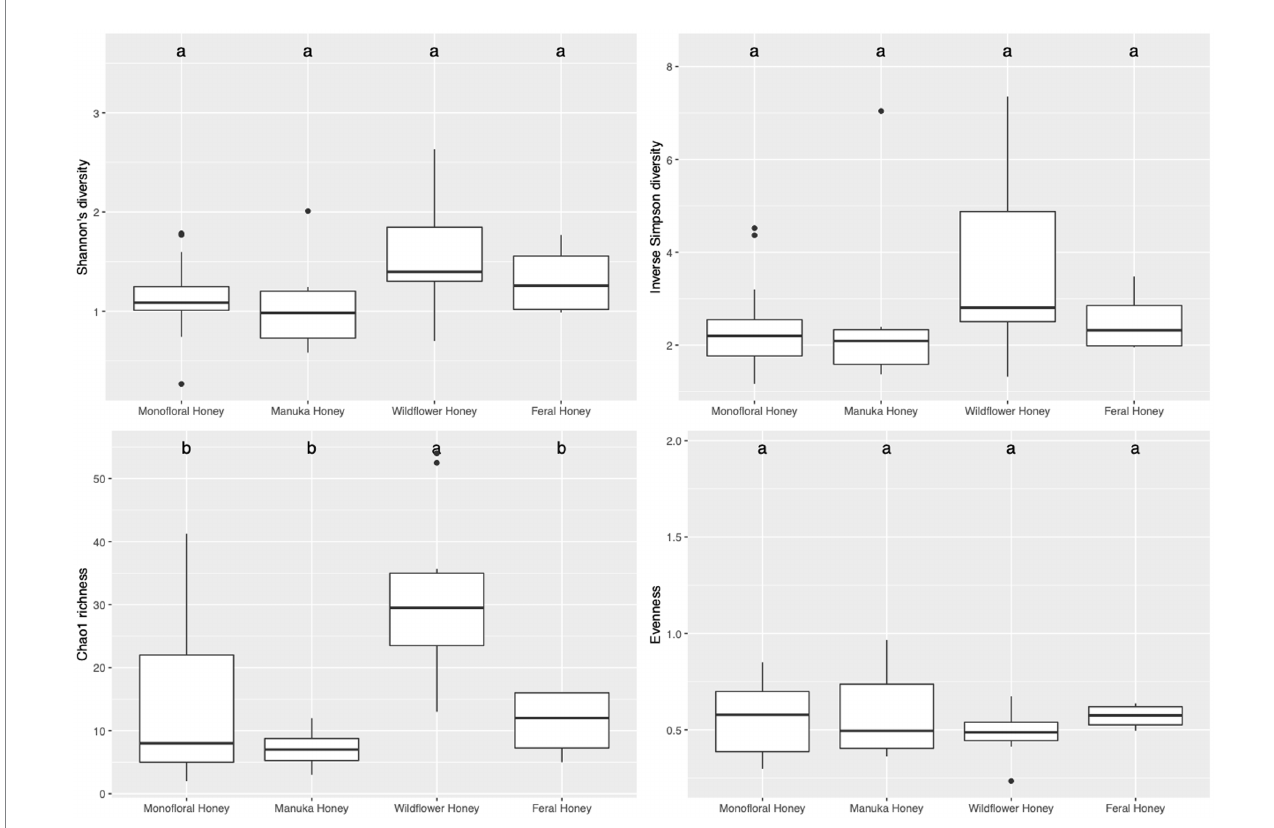
FIGURE 5 Alpha diversity metrics of honey fungal community. Diversity was measured with Shannon and inverse Simpson indices. Richness was measured with Chao index. Evenness was measured with Pielou’s evenness index. Comparison between honey sample types was performed with ANOVA and Tukey’s honest significance test. Letters above the bar plots represented shared significance groups ( p -value cutoff is